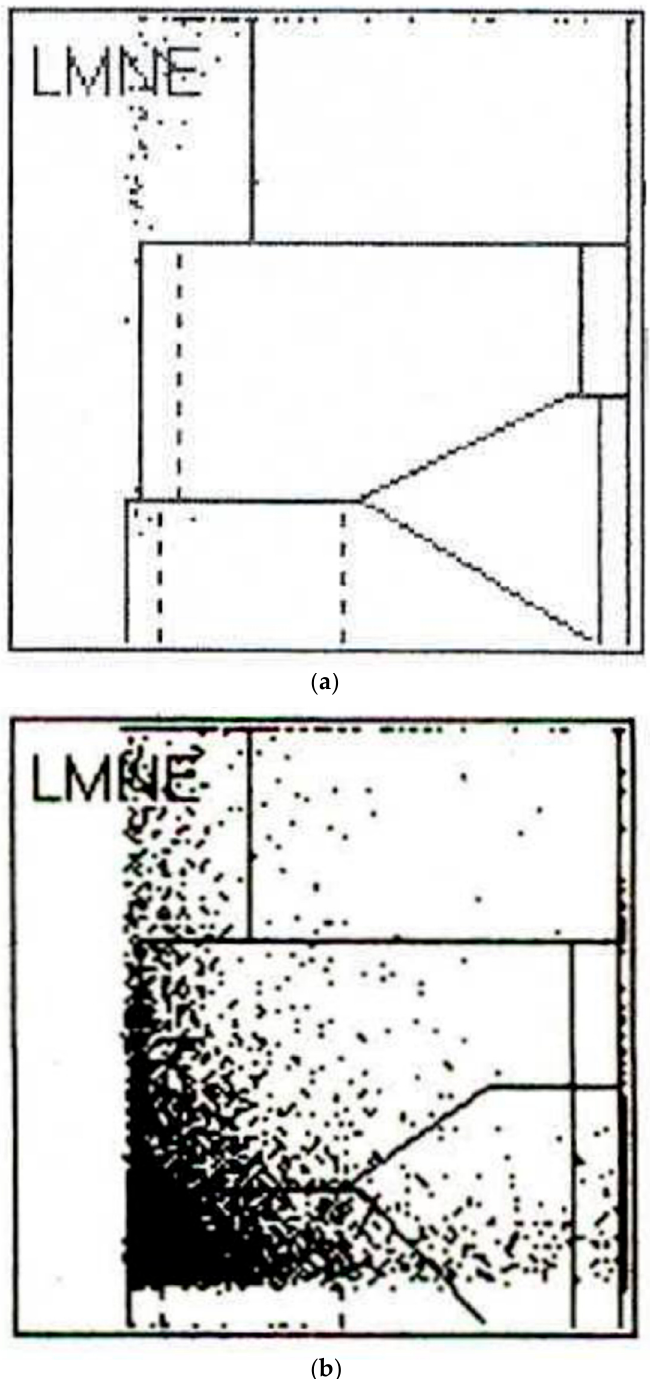
Figure 2. LMNE matrix of a type I (abrasion type) with a cloud in the NOISE ‐ area of a 65 ‐ year ‐ old male patient with an aspirate of the hip arthroplasty 15 years postoperative. The measured cell count was 1500 cells/ μ L.